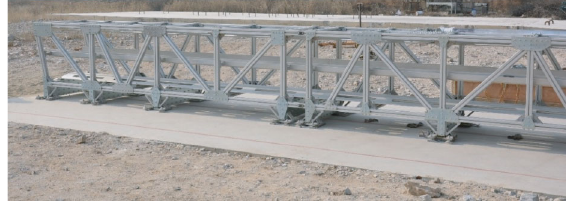
Figure 5: Missile-carrying unit of a set of